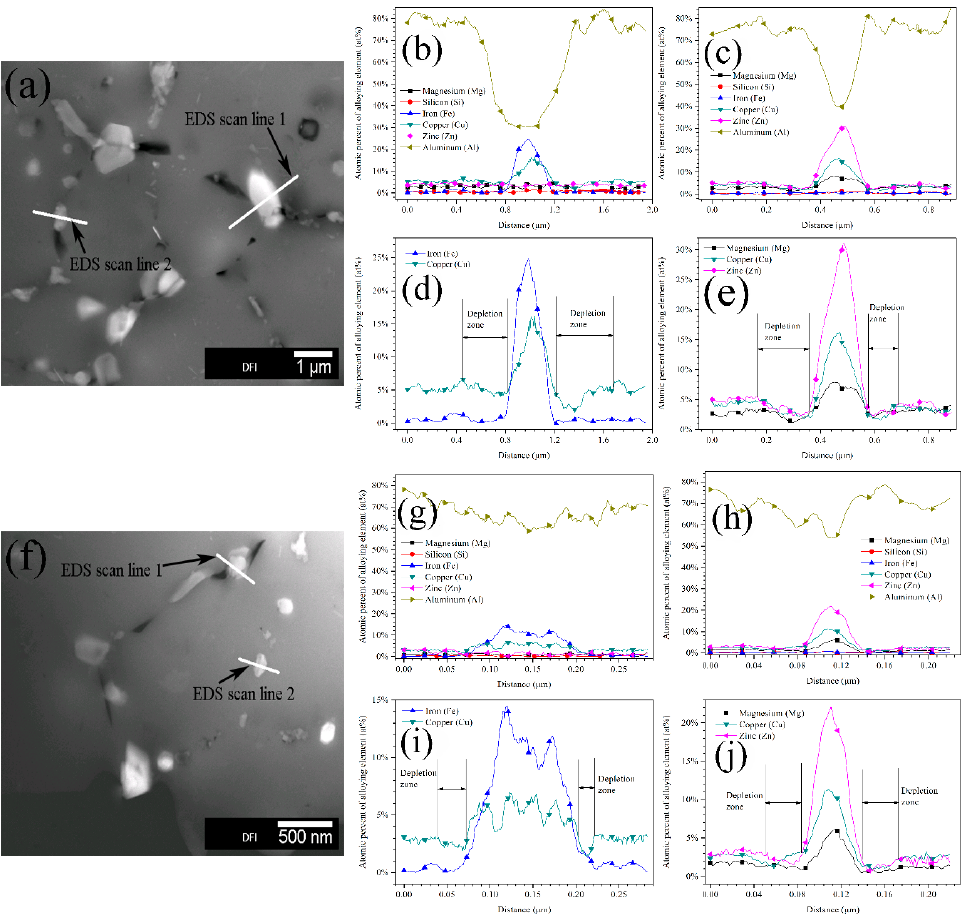
Figure 4. Transmission electron microscope (TEM) images of intermetallic phases in alloys matrix: ( a ) coarse grain zone, ( b ) energy dispersive X-ray spectroscopy (EDS) results of scan line 1 on coarse grain zone, ( c ) EDS results of scan line 2 on coarse grain zone, ( d ) element depletion zone near cathodic phase on coarse grain zone, ( e ) element depletion zone near anodic phase on coarse grain zone; ( f ) fine grain zone, ( g ) EDS results of scan line 1 on fine grain zone, ( h ) EDS results of scan line 2 on fine grain zone, ( i ) element depletion zone near cathodic phase on fine grain zone, and ( j ) element depletion zone near anodic phase on fine grain zone.